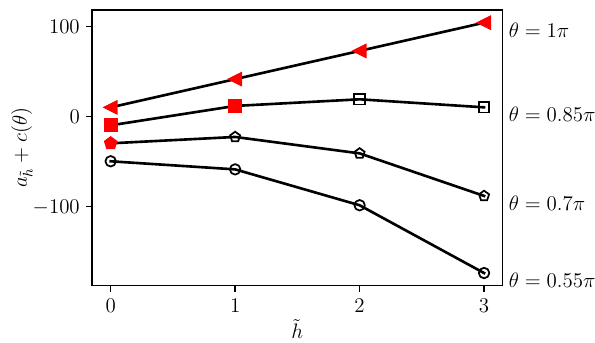
’s (the imaginary part of the effective action at the ˜ h -th saddle h . This implies (3.42) that the thimble T ˜ h ≤ a ˜ h +1